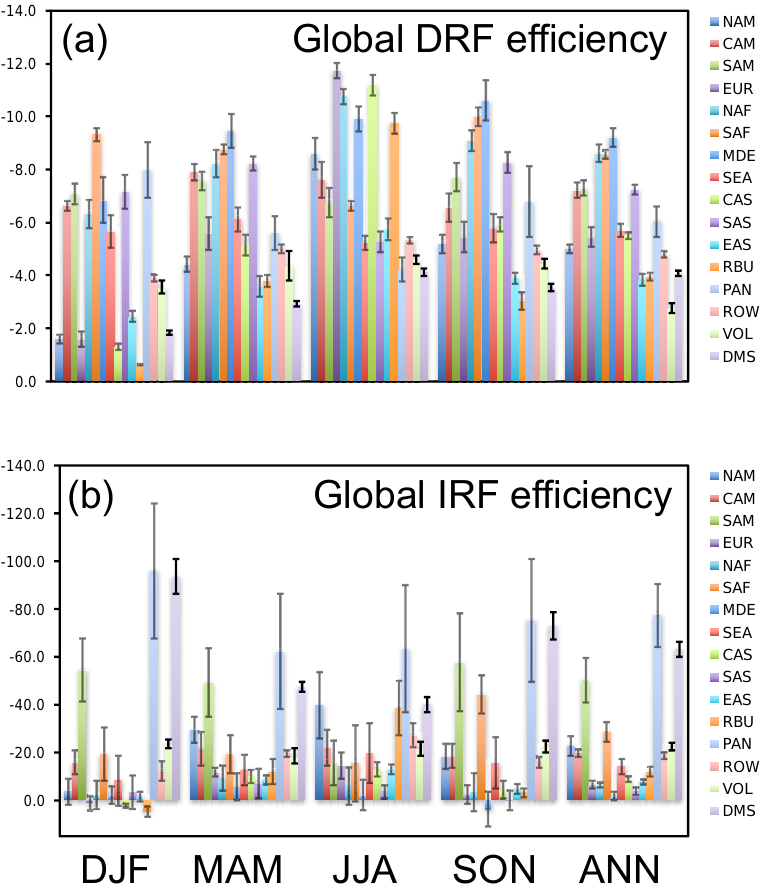
Figure 11. Seasonal and annual mean global sulfate (a) direct and (b) indirect radiative forcing efficiency (mWm − 2 (Tg Syr − 1 ) − 1 ) of the 16 tagged source regions/sectors. The sulfate radiative efficiency is defined as the global sulfate radiative forcing divided by the corresponding scaled annual sulfur emissions (seasonal emissions multiplied by 4). Error bars indicate 1 σ of mean values during years